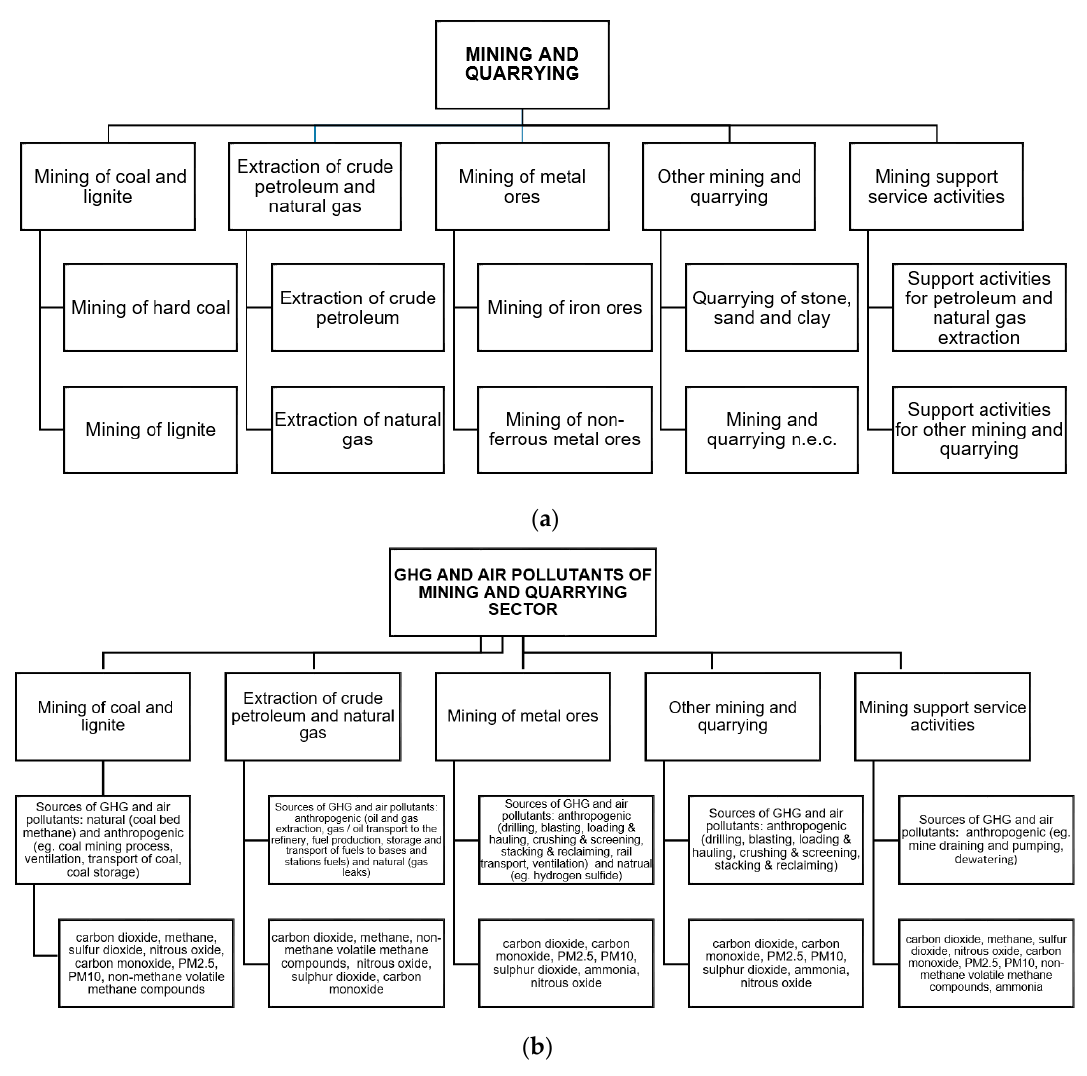
Figure 3. Division of the mining and quarrying sector by Statistical classification of economic activities in the European Community (NACE) Rev. 2 activity ( a ) and main sources of greenhouse gas and air pollution emissions into the atmosphere from the mining and quarrying sector ( b ) (own elaboration based on [20]).